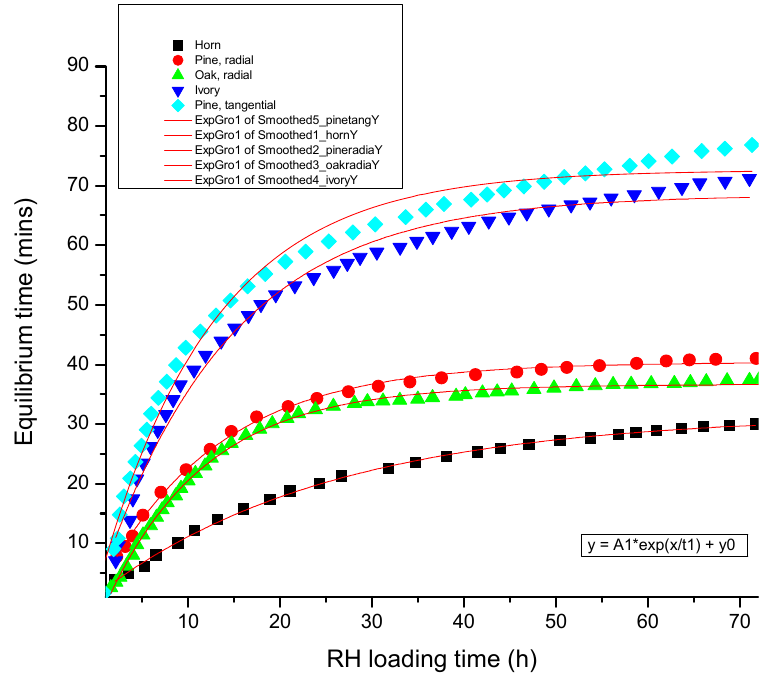
Figure 8. Mean equilibrium time of different